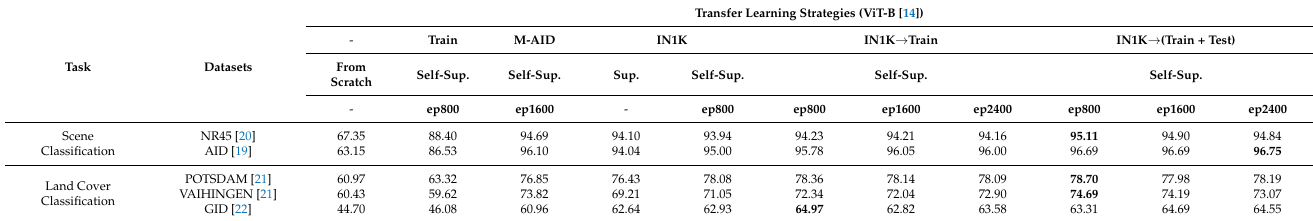
Table 2. The comparison of knowledge transfer learning strategies on optical remote sensing down- stream